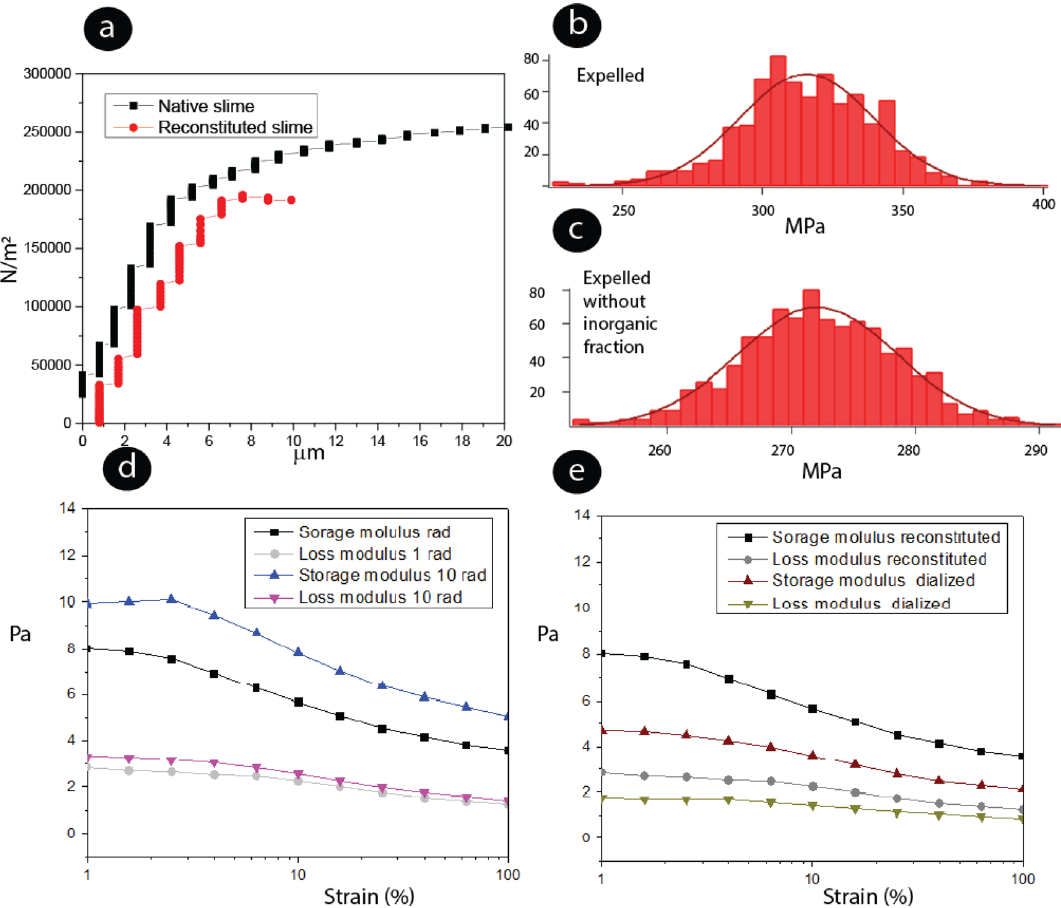
Figure 7. Rheological characterization of expelled slime. ( a ) Effect salt remotion on the slime’s pull-off adhesion force ( b ) and ( c ) Young’s modulus calculated by AFM nanoindentation. The mass of the native and non-dialyzed slime was approximately 0,8 mg. Histograms from the expelled slime and expelled without the inorganic fraction. ( d ) Storage and loss modulus of the slime reconstituted in acetic acid 0.01 wt% and dialyzed at different frequencies, concentration 40 mg/mL. The acetic acid at 0.1 wt % was used initially to solubilize the slime and further diluted with